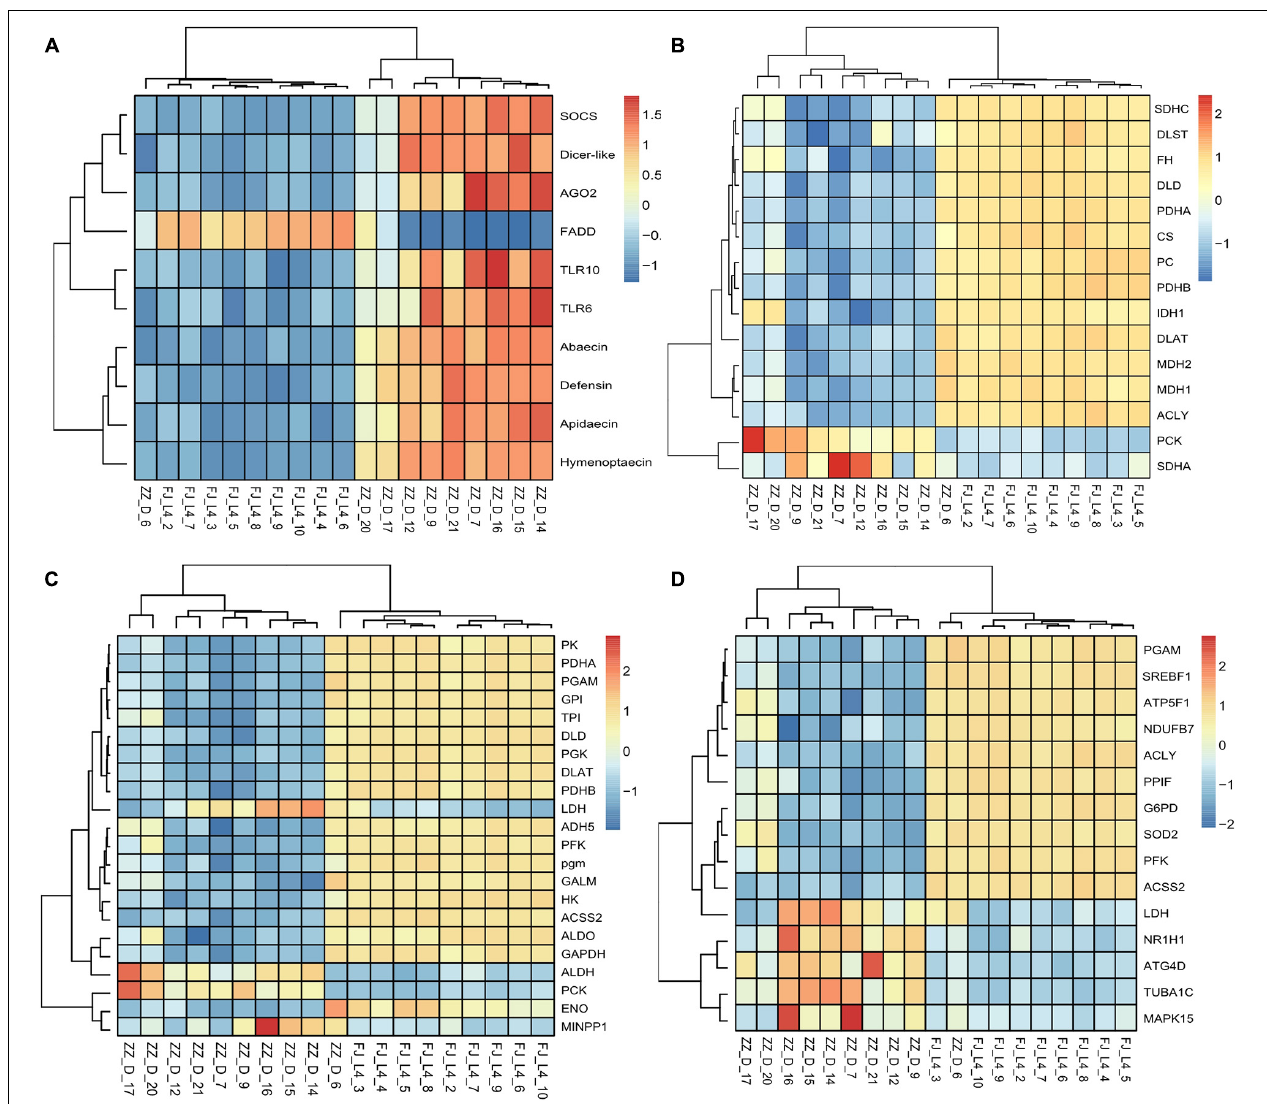
FIGURE 2 | Heatmaps of candidate differentially expressed genes (DEGs). The function “aheatmap” in the R package named “NMF” were used to analyze the clustering. The distance measure used in clustering rows and columns was “euclidean,” and the clustering method used to cluster rows and columns was hclust with “complete.” (A) The expression pattern of the differentially expressed genes including antimicrobial peptides, RNA interference, and Toll like receptor gene expression. (B) The expression pattern of the differentially expressed genes involved in the tricarboxylic acid (TCA) cycle of energy metabolism. The rate-limiting enzyme including DLD , CS , DLST , and IDH1 were down-regulated in the infected group. (C) The expression pattern of the differentially expressed genes involved in the Glycolysis. The rate-limiting enzyme including HK , PFK , and PK were down-regulated in the infected group. (D) The expression pattern of the differentially expressed genes involved in the Sirtuin pathway. The genes whose RNAseq data were consistent with the qPCR verification data were ACLY , ATP5F1B , G6PD , and PFK . These genes are also closely involved in energy